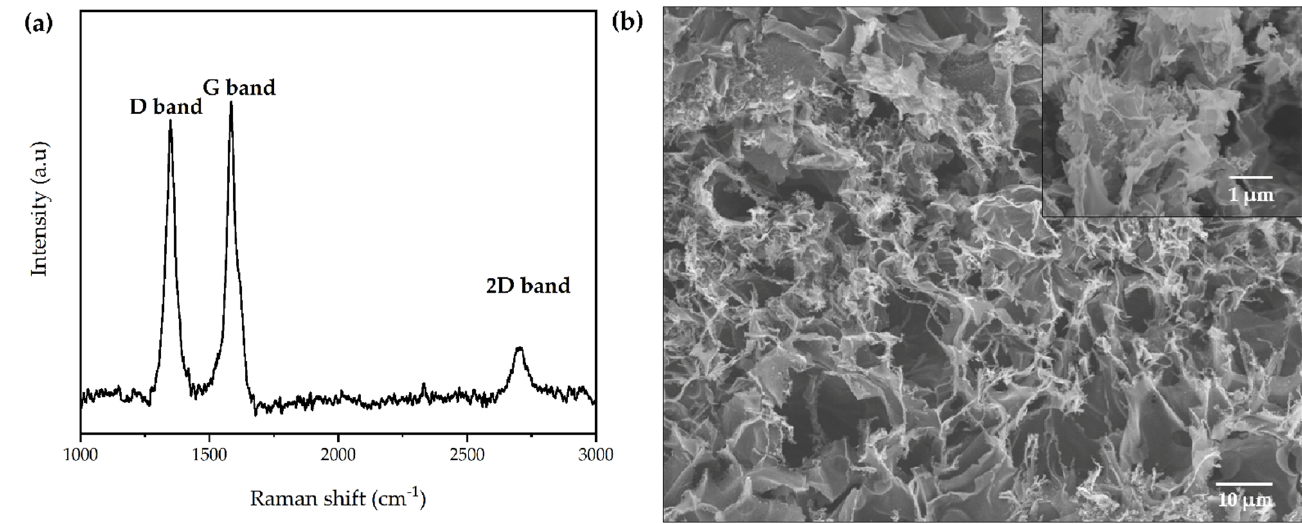
Figure 4. ( a ) Raman spectra and ( b ) FESEM of the surface microstructure of LIG produced from DLW process on PI sheets.